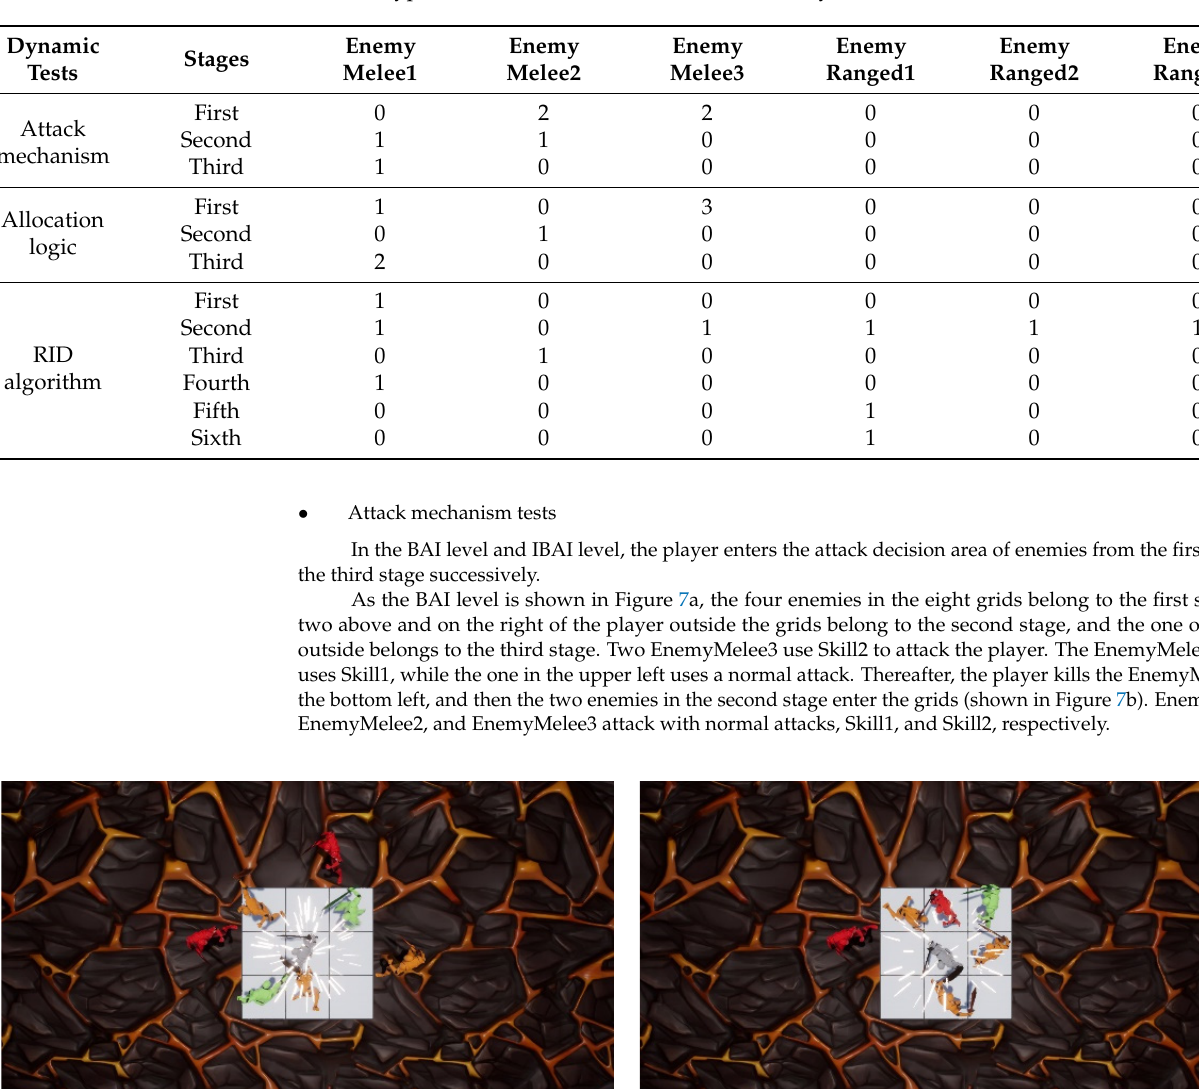
Table 5. Type and number of enemies used in each dynamic test.